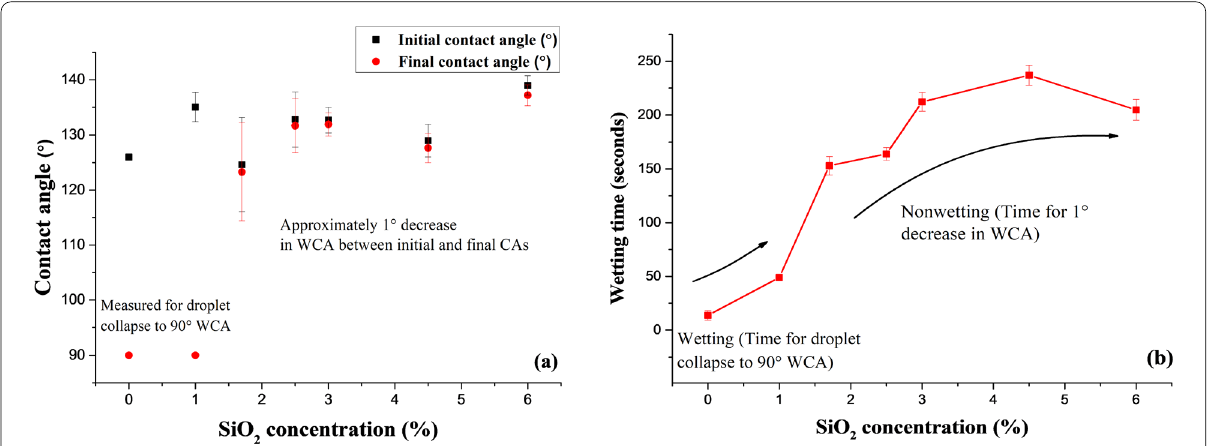
Fig. 8 a Variation in the initial WCAs of PHBV/SiO 2 composite fibrous mats with increasing concentrations of SiO 2 –NPs. b Evaluation of droplet collapse time of PHBV/SiO